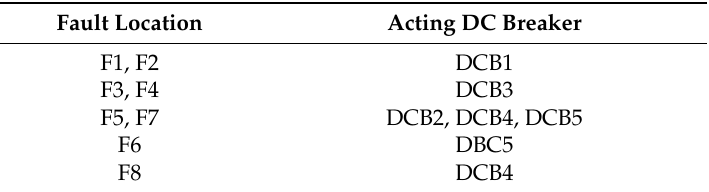
Figure 2. DC breaker configuration and pole-to-pole short circuit fault location. Table 2. System fault clearing strategy.